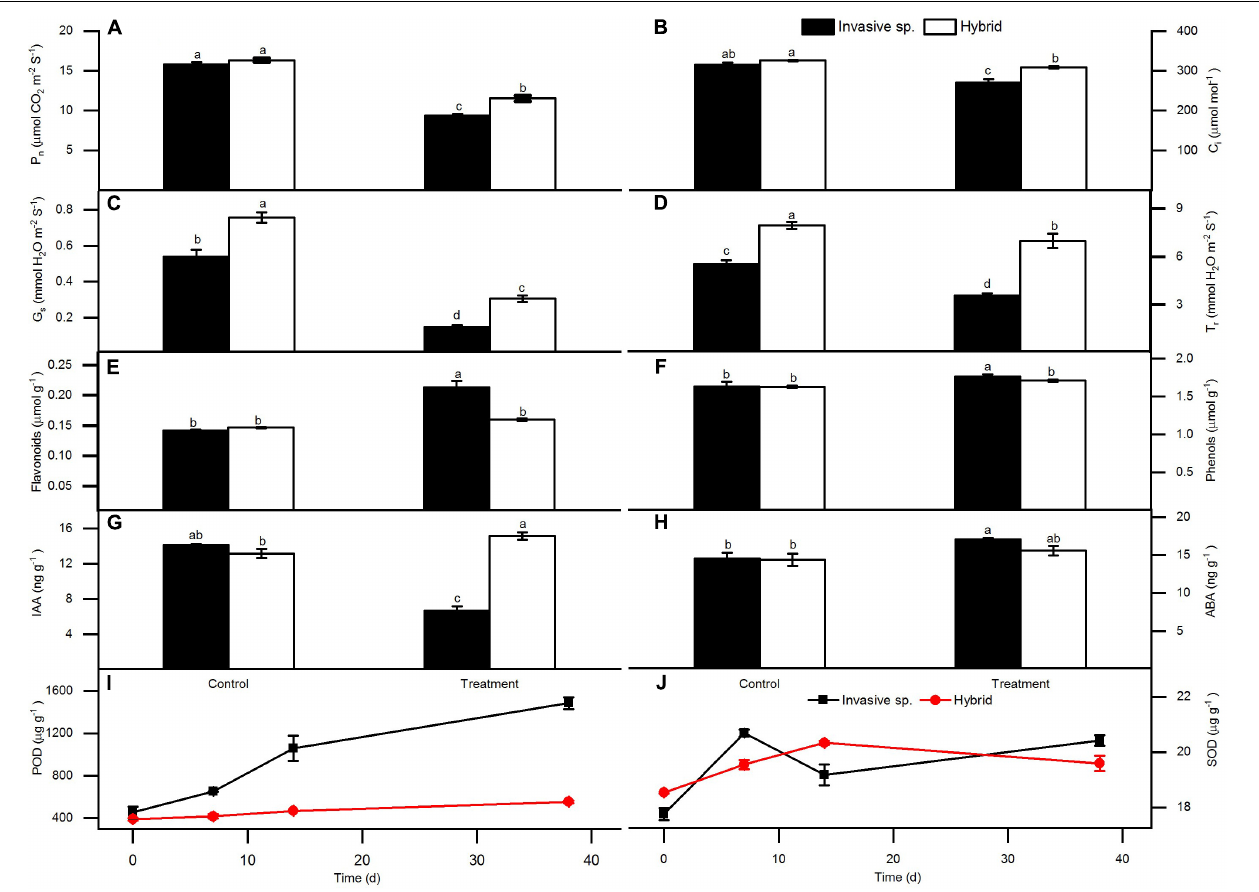
FIGURE 2 | Under Cd stress, the changes of two species in photosynthetic indexes of leaves: Net photosynthetic rate (Pn) (A) , intercellular CO 2 concentration (Ci) (B) , stomatal conductance (Gs) (C) , and transpiration rate (Tr) (D) ; non-enzymatic antioxidant content: flavonoids (E) , total phenols (F) ; hormone contents of plant endogenous auxin IAA (G) and abscisic acid ABA (H) ; enzymatic antioxidant content: peroxidase POD (I) and superoxide dismutase SOD (J) , show Mean ± SE, One-way ANOVA, and the letters on the column indicate the difference.